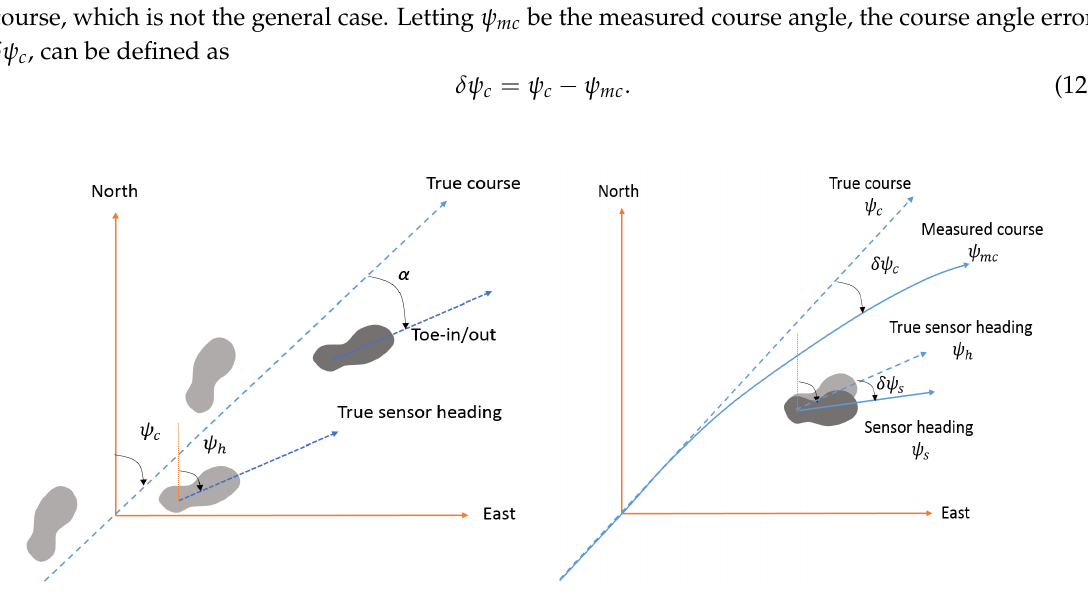
Figure 4. Geometry and kinematic relation for walking gait and